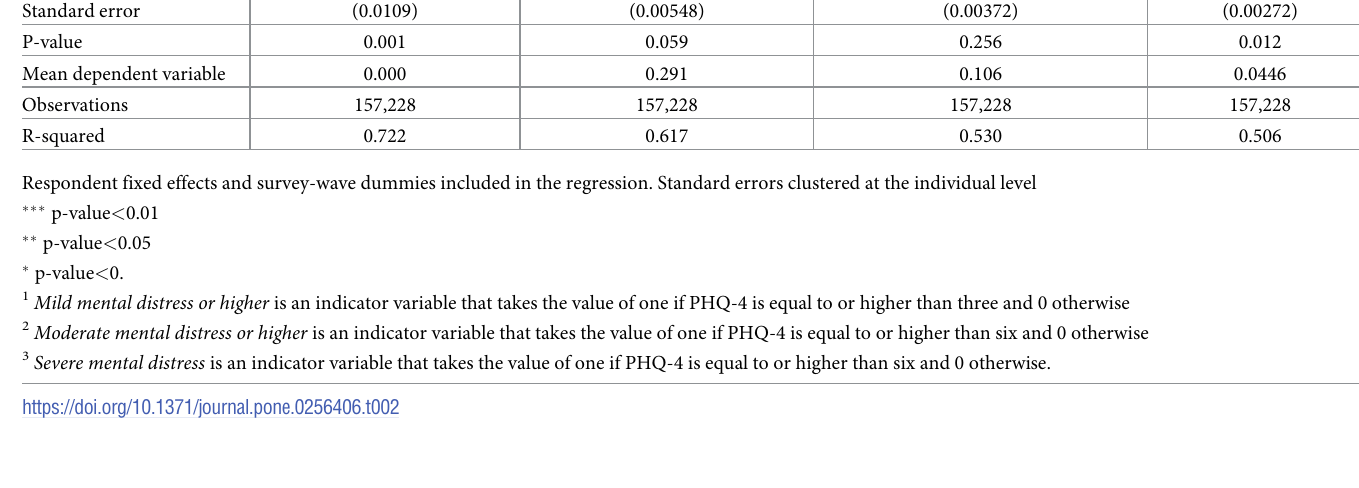
the standardized PHQ-4 score fell by 0.03 standard deviations(p-value < 0.01) immediately after vaccination and was further reduced by 0.003 standard deviations per ten days after vacci- nation, although not significantly (p-value = 0.27)